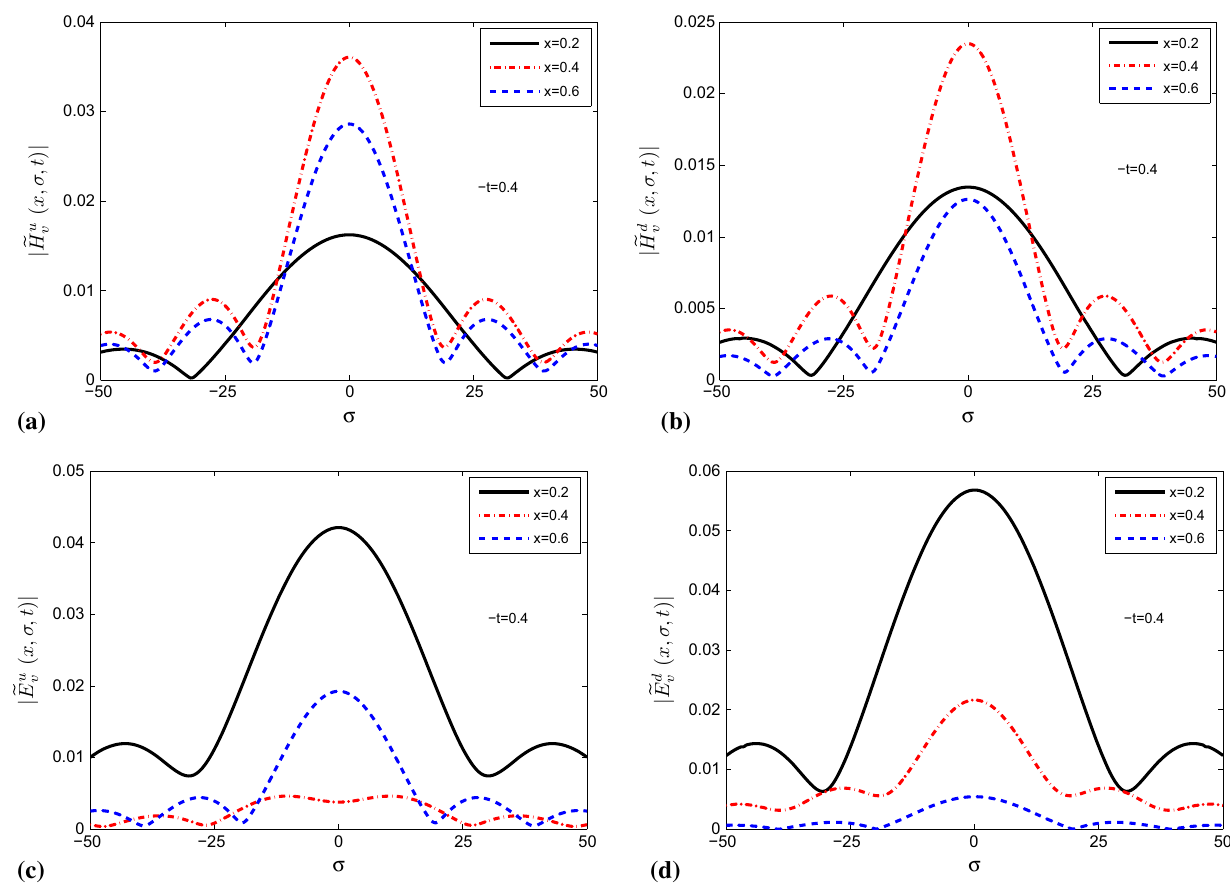
Fig. 9 (Color online) Plots of the chiral-odd GPDs in longitudinal impact space vs. σ and different values of x , for a fixed value of − t = 0 . 4 GeV 2 . The left panel is for the u quark and the right panel is for the d quark. For − t = 0 . 4 GeV 2 , ζ max ≈ 0 .